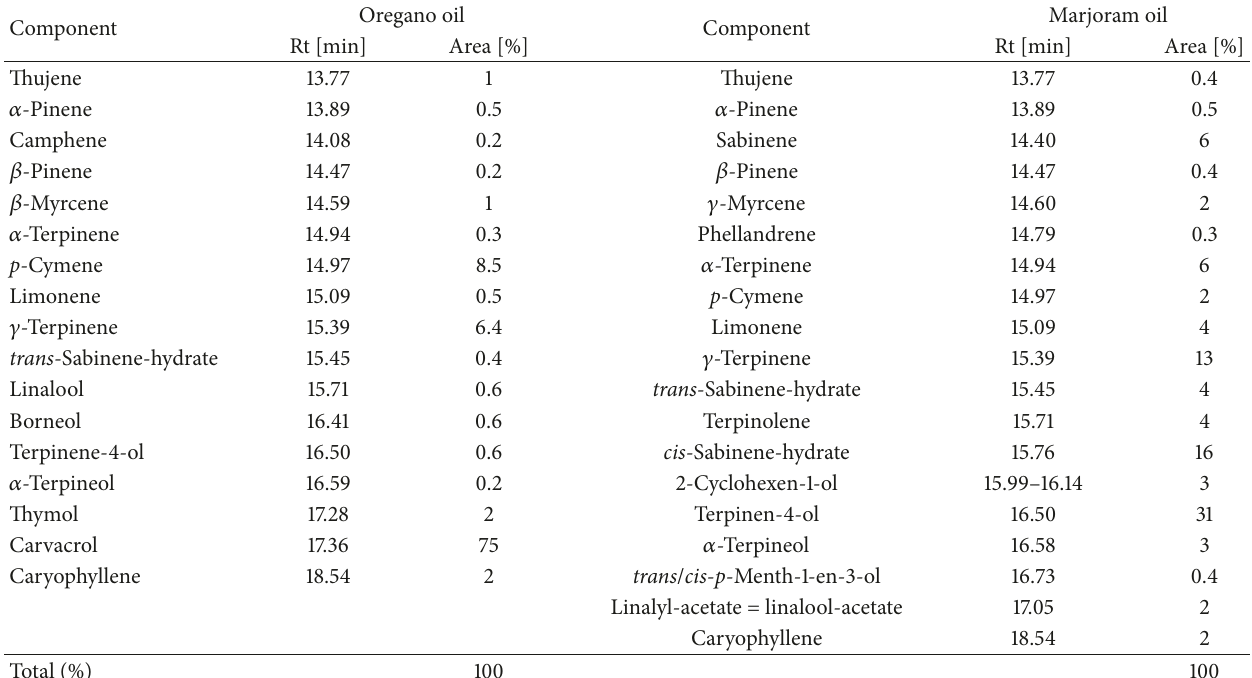
Table 1: Composition of the oregano and marjoram essential